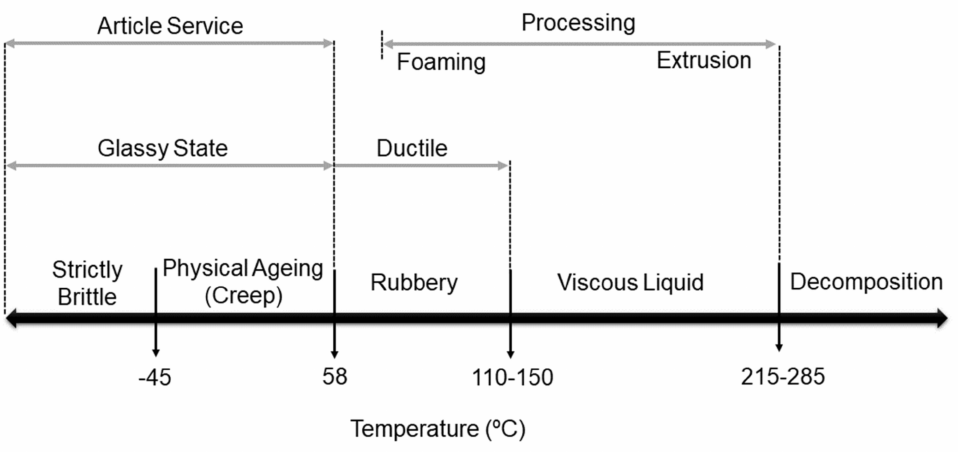
Figure 4. Metastable phases of high Mw amorphous PLA adapted from